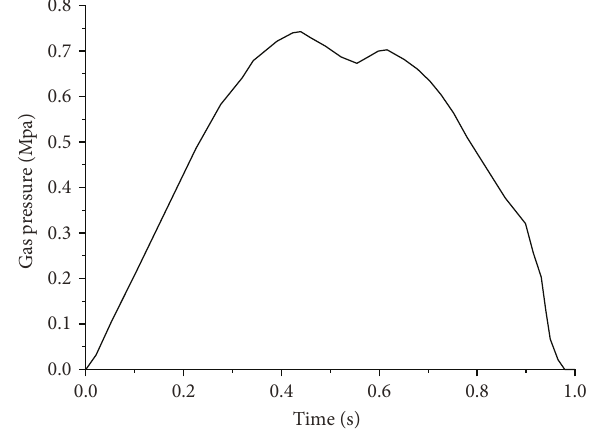
Figure 3: Gas pressure curve.